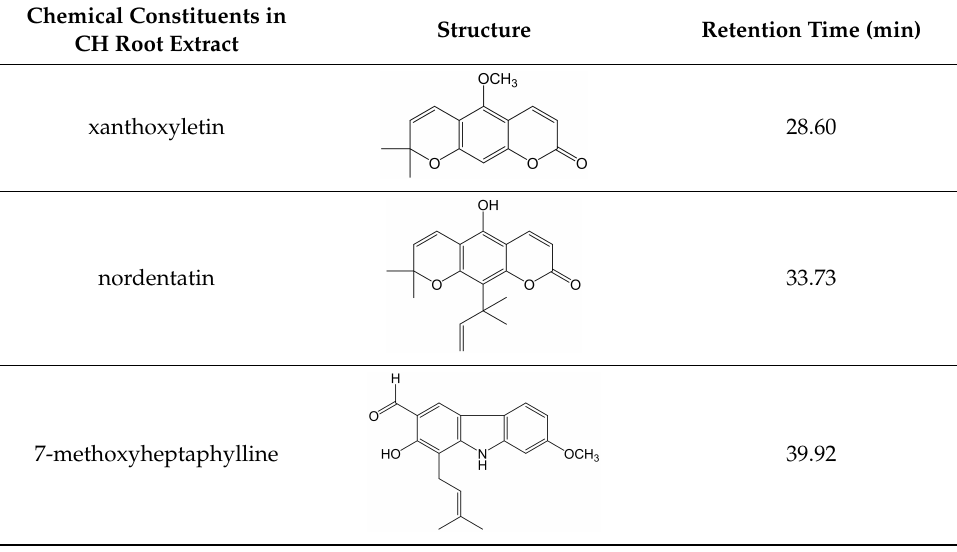
Figure 1. HPLC chromatograms of standards ( A ) and the root extract of C. harmandiana ( B ) using a Phenomenex C 18 column (250 mm × 4.6 mm, 5 µ m) and a gradient mobile phase of 0.1% formic acid ( A ) and acetonitrile ( B ) at wavelength 270 nm. Xanthoxyletin (1), osthol (2), nordentatin (3), 7-methoxyheptaphylline (4), heptaphylline (5) and dentatin (6). Table 1. The retention time of five marker compounds in CH root extract.